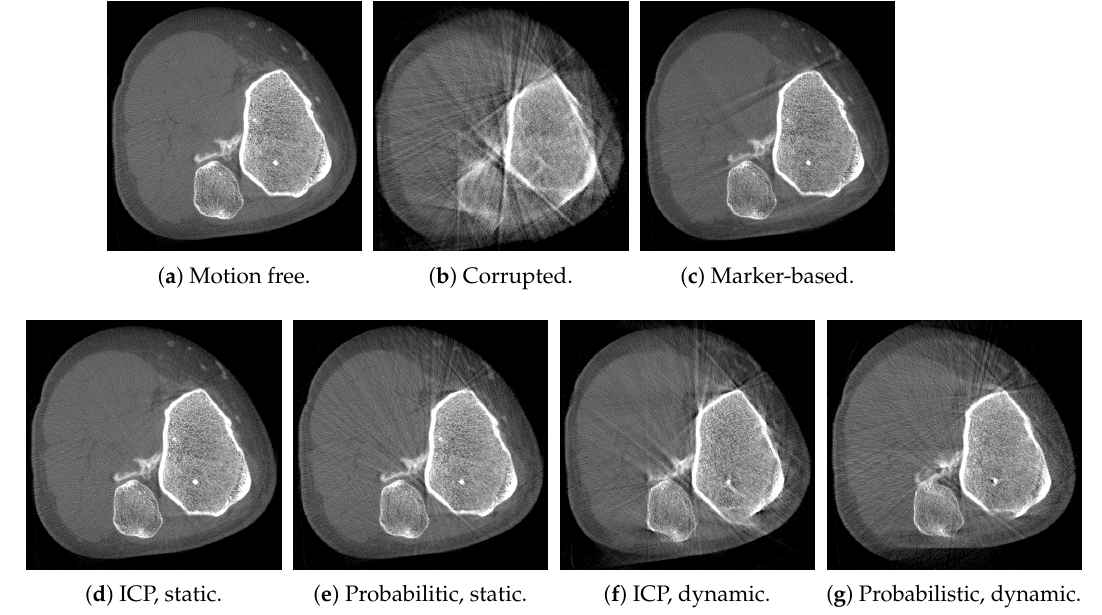
Figure 4. Reconstruction results of dataset 1: axial slices of the motion free reference volume ( a ); the motion corrupted ( b ); the marker-based corrected ( c ); and the proposed methods ( d – g ).